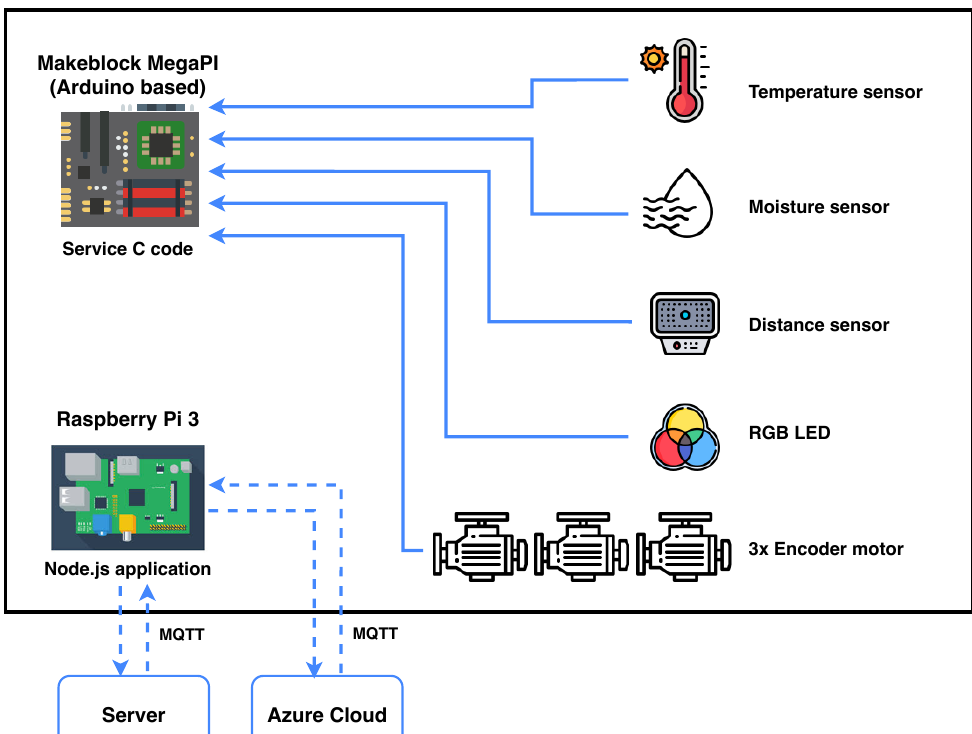
Figure 14. Illustrative diagram of mechanical and electronic elements of mechatronic